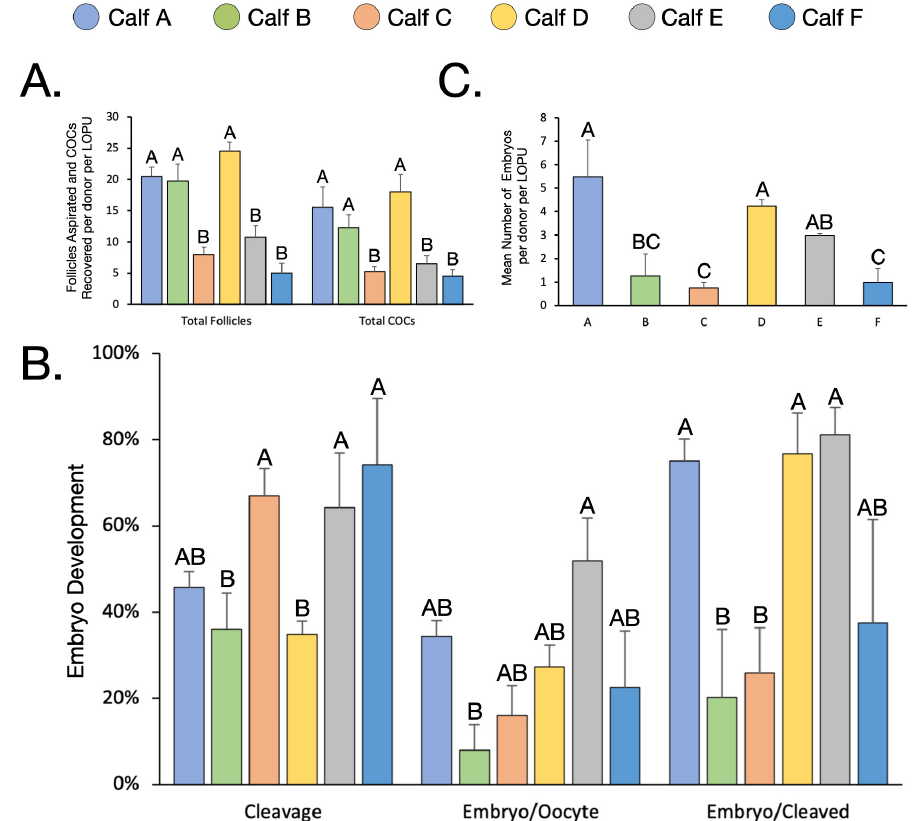
Figure 3. The effect of individual variation. ( A ). The mean number of follicles aspirated and COCs recovered per animal. ( B ). The embryo development rates per animal. ( C ). The mean number of embryos produced per animals per LOPU. Values within the same chart with different script (A–C) differ significantly ( p < 0.05).